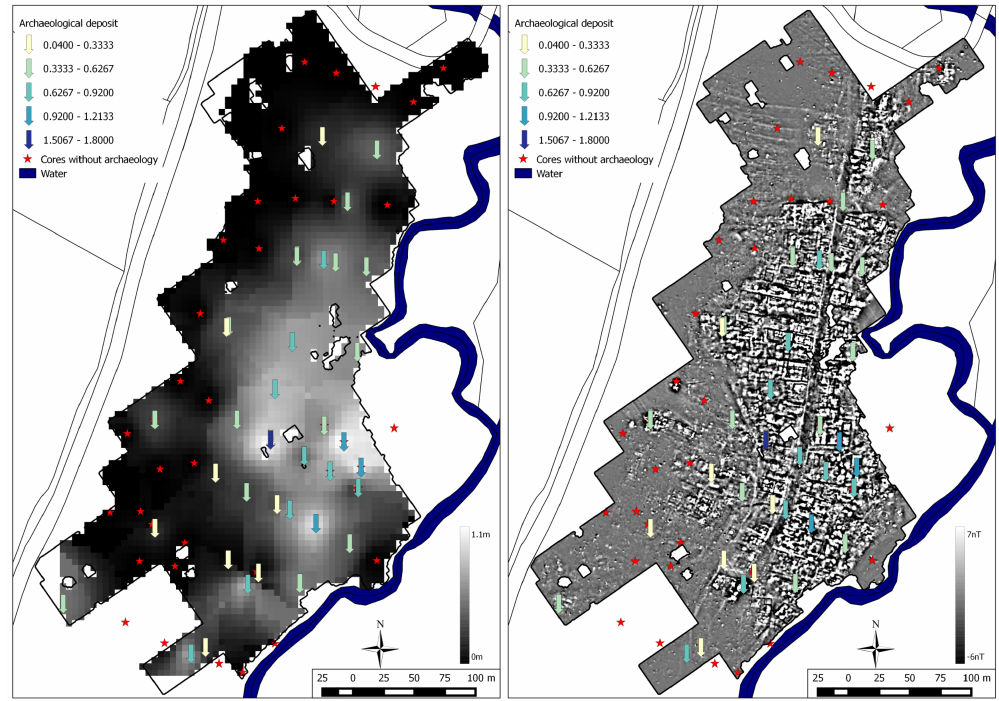
Figure 14. ( a ) Cores of Zaldua area over the interpolated raster for the thickness of the archaeological deposit. ( b ) Cores over the magnetic gradiometer results. Cores where no archaeological deposits were identified are signalled in red. The arrow’s colour reflects the thickness of the identified archaeological